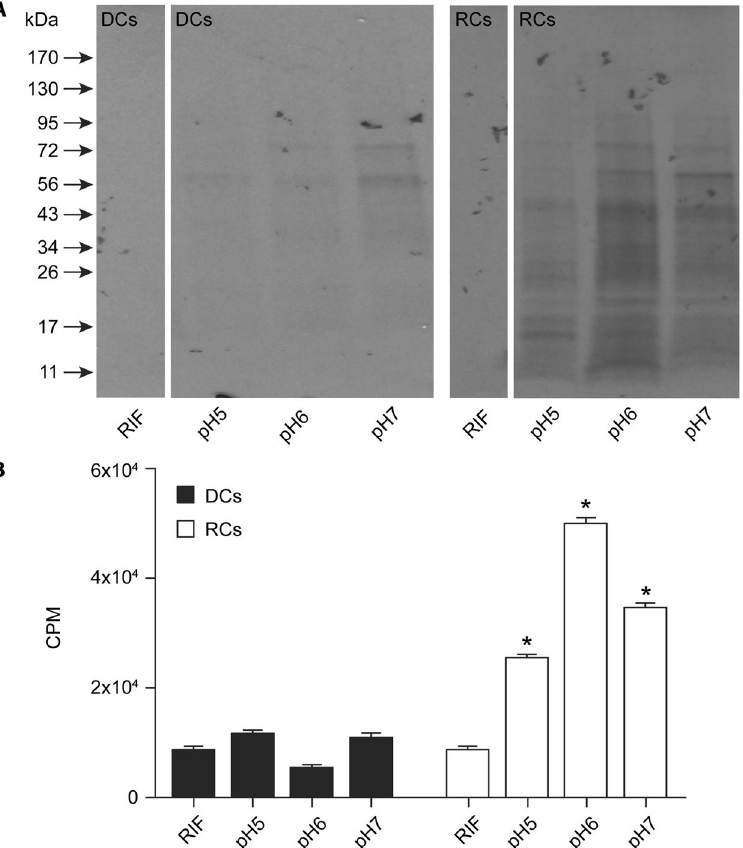
Figure 4. Impact of pH variations assessed on the 35 S Cys-Met incorporation into E . chaffeensis cell-free organisms. ( A ) Autoradiography imaging was performed to assess the impact of three different pH units; 5, 6 and 7 for DCs and RCs. In the first lane, we included rifampin (RIF) containing sample with the media at pH 5.0 to serve as a negative control ( B ). As in panel A , except that the scintillation counting data were presented. Significant change noted relative to RIF controls are identified with a * above each bar. (Note: Original images used in preparing Figure 4A were provided as the Supplementary information